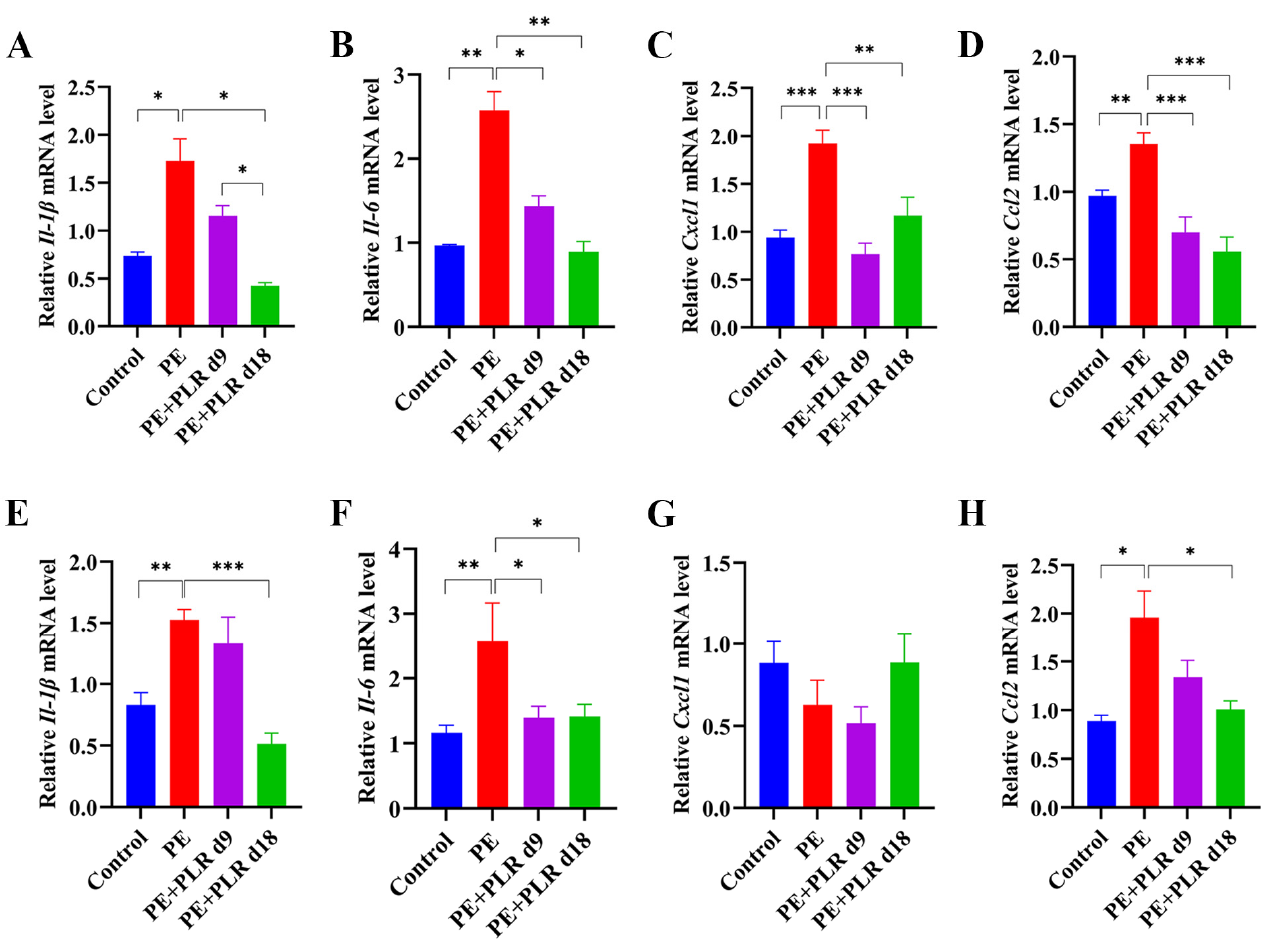
Figure 4. PLR attenuated gut and placental inflammation in PE mice. ( A – D ) Relative mRNA levels of interleukin-1 β ( Il-1 β ), interleukin-6 ( Il-6 ), C-X-C motif chemokine ligand 1 ( Cxcl1 ), and C-C motif chemokine ligand 2 ( Ccl2 ) in placenta. ( E – H ) Relative mRNA levels of Il-1 β , Il-6 , Cxcl1 , and Ccl2 in the colon. In this figure, n = 6 for each group. Data are expressed as the mean ± SEM. * p < 0.05, ** p < 0.01, *** p < 0.001 (ANOVA test).